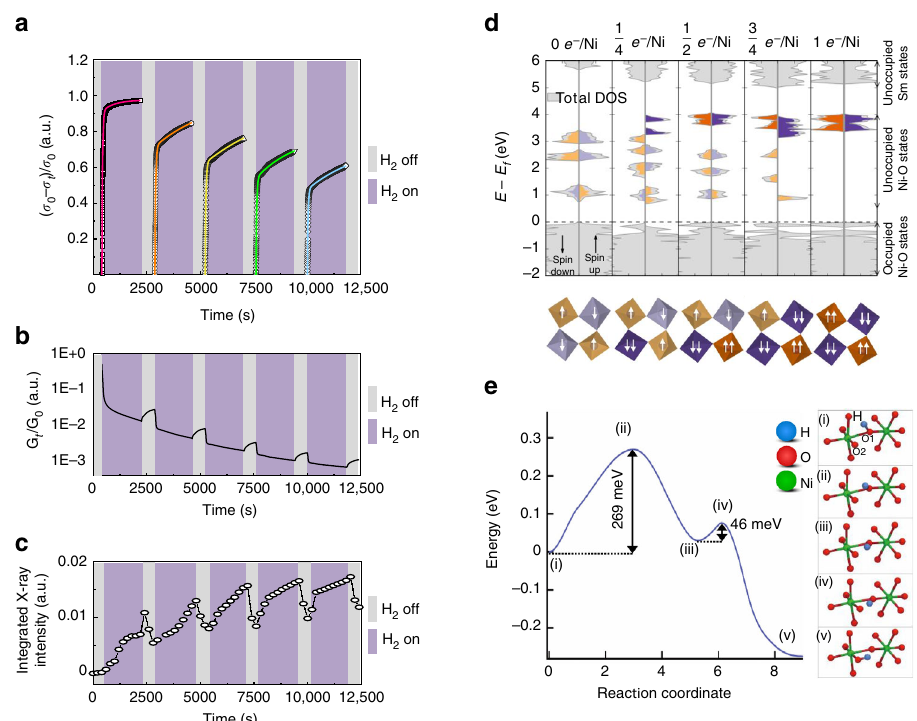
Fig. 2 Mechanism of habituation in a perovskite nickelate. a In situ visualization of habituation phenomenon, i.e., exponential decrease of conductivity change upon environmental exposure (the dots represent the experimental data and the solid lines are fi ts.). σ 0 and σ t are initial and dynamical conductivity, respectively. b The conductance changes in response to different environments (decrease in H 2 and increase in air) showing inherent plasticity similar to what is observed in biological synapses. G 0 and G t represent initial and dynamical conductance, respectively. c Structural lattice breathing monitored by in situ synchrotron X-ray diffraction. The integrated intensities of x-ray diffraction peak at q z = 2.98 Å − 1 related to H-SmNiO 3 ( H-SNO ) are shown (see Supplementary Fig. 4). d First-principles calculation of electron-doped SNO. The upper fi gure shows density of states ( DOS ), in gray , at different doping levels from 0-1 added e − per Ni site. The unoccupied projected DOS ( PDOS ) on each nickel site is shown in orange and purple . The difference in the total DOS and the PDOS is due to the strong hybridization of the Ni and O states resulting from the covalent nature of the NiO 6 octahedra. The lower fi gure shows the occupied Ni e g levels for the corresponding doping levels. Same color legend is used and the darker colors indicate Ni with two occupied e g states. e Atomic-scale pathway, and the associated energy barriers for proton migration between two neighboring O atoms labeled as O1 and O2 in (i) within a NiO 6 octahedron in a monoclinic SNO crystal. The potential energy along the most preferred diffusion pathway (as obtained from nudged-elastic band density functional theory ( DFT ) calculation) is shown on the left , while selected con fi gurations along this pathway labeled (i) – (v) are depicted on the